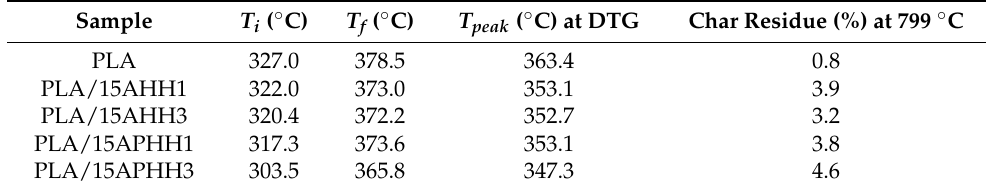
Figure 5. TGA ( a ) and DTG ( b ) thermograms of PLA and its biocomposites for 15 wt. % filler loading. Table 4. Data obtained from TGA results of PLA and its